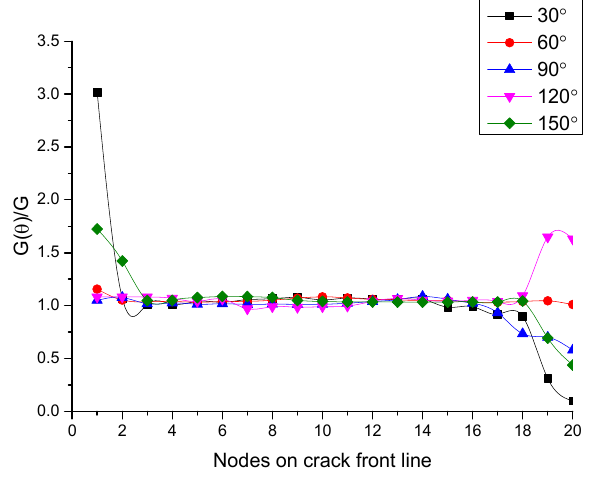
Figure 17. G ( θ ) /G for each expansion angle. Figure 17. G(cid:4666)θ(cid:4667)/G for each expansion angle.